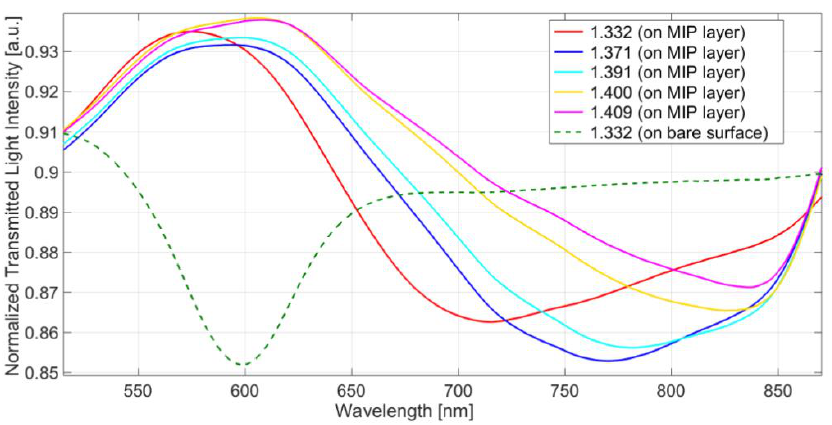
Figure 5. Comparison of the spectra of an SPR-MIP sensor (C1-3) in water–glycerol solutions with